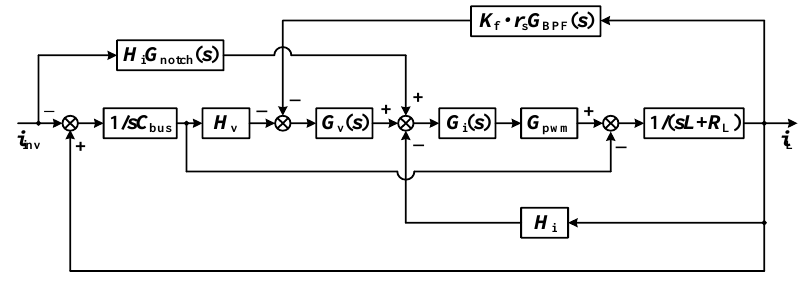
Figure 6. Block diagram for the gain from i inv to i L .